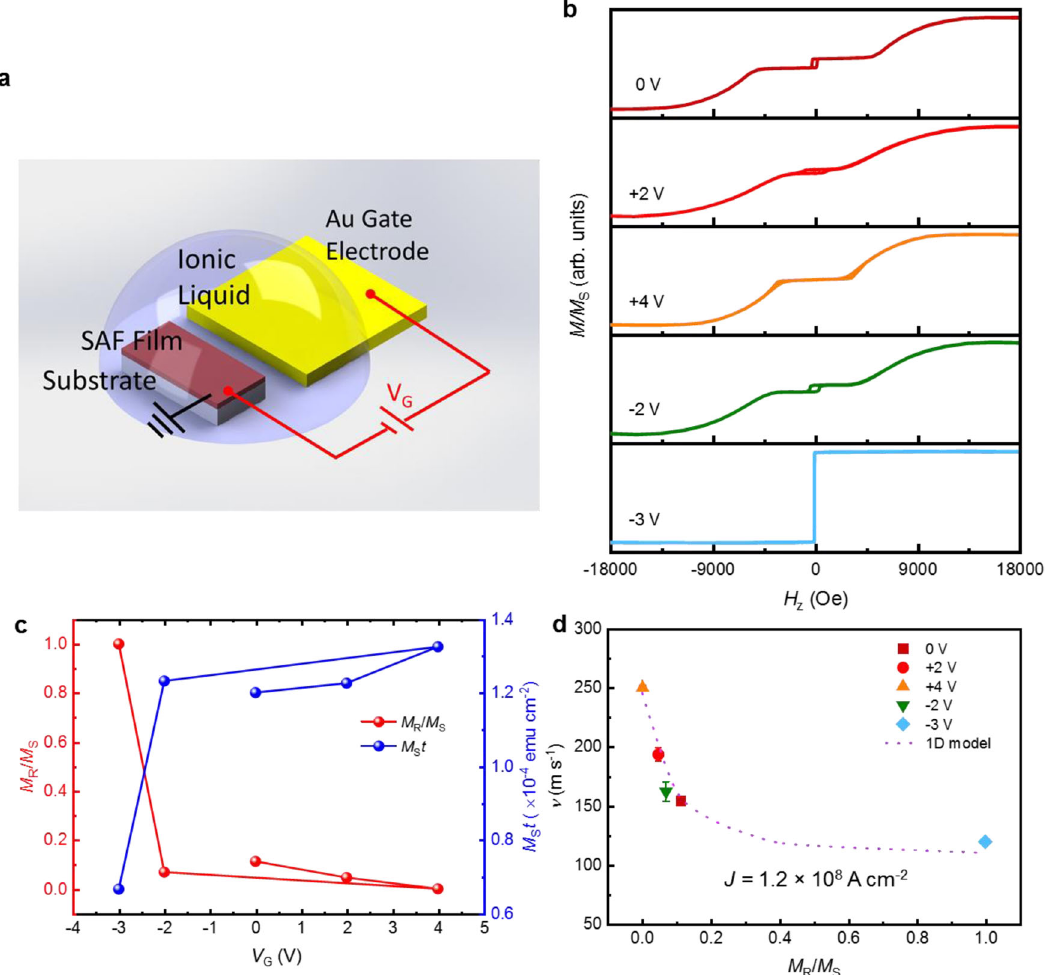
Fig. 2 ILG-induced magnetization changes in SAF structures. a Schematic illustration of ionic liquid gating of the pristine SAF fi lms. b Magnetic hysteresis loops obtained from ex situ SQUID measurements for several V G applied in the following sequence: 0 V (pristine state), + 2 V, + 4 V, − 2 V, and − 3 V. c V G dependence of M R / M S (left axis) and M S t (right axis). d DW velocity at a fi xed current density (1.2 × 10 8 A cm − 2 ) plotted as a function M R / M S . The dotted line corresponds to simulation results based on a 1D analytical model. The error bars in d correspond to 1